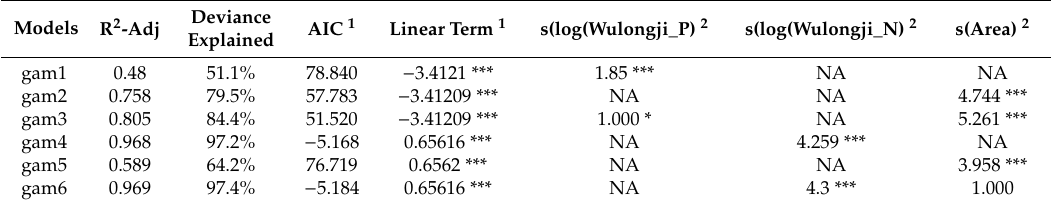
Table 1. The statistical results of the generalized additive models (GAMs).